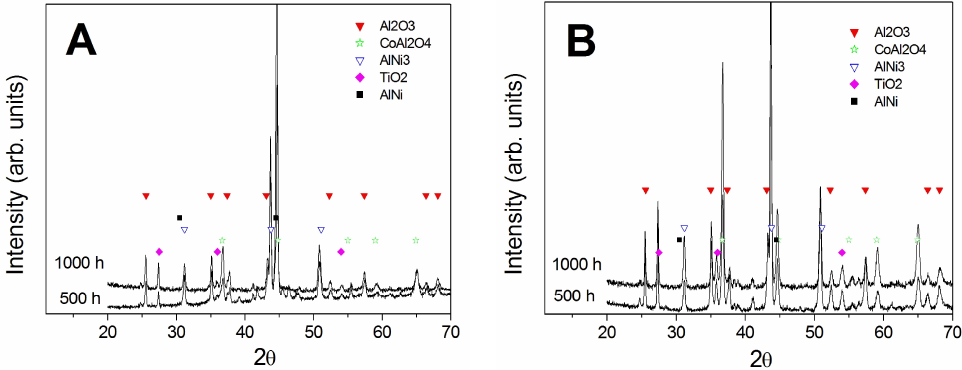
Figure 6. Surface XRD pattern of IN738 + Pack aluminizing + Post treatment ( A ) and IN738 + IL aluminizing + post treatment ( B ), respectively, after 500 and 1000 h of isothermal test (1000 °C).